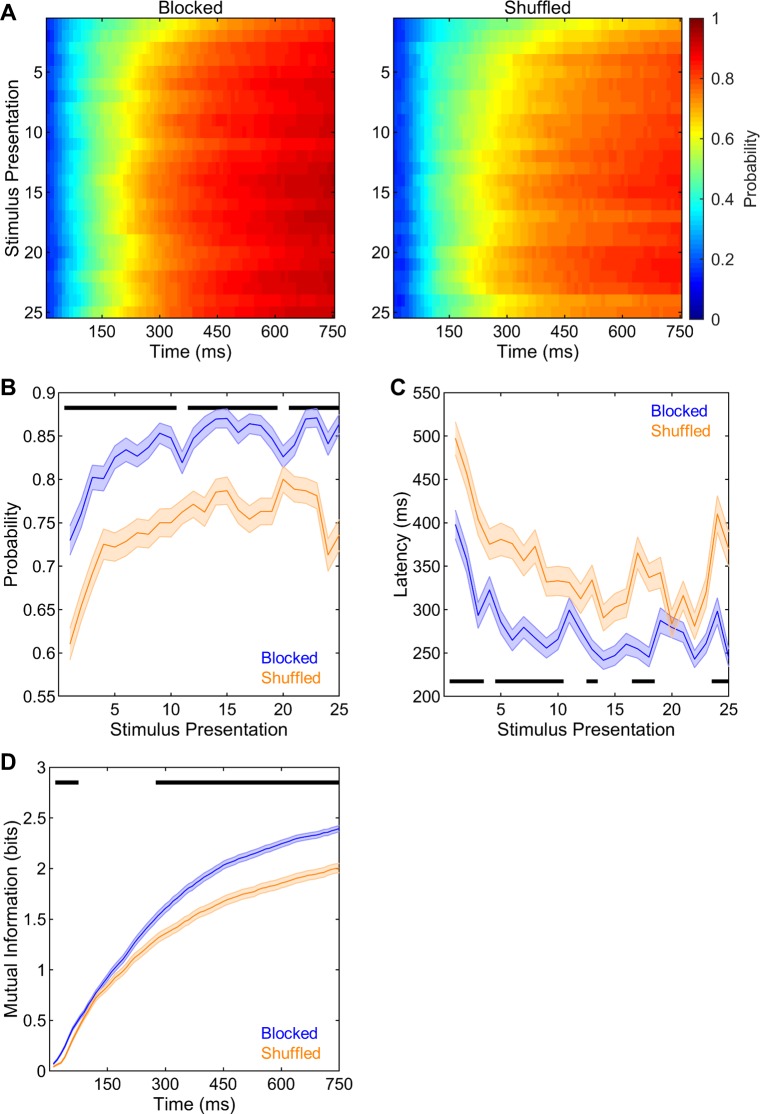
Neural decoding in blocked and shuffled sequences.(A) Neural decoding accuracies were analyzed across time points along the stimulus duration and stimulus presentations in blocked and shuffled sequences. (B) Correct neural decoding probabilities across stimulus presentations were higher in the blocked than in the shuffled sequence. (C) Correct neural decoding latencies across stimulus presentations were shorter in the blocked than in the shuffled sequence. (D) Mutual information was higher in the blocked than in the shuffled sequence between the 2nd and 7th time bins (20–70 ms) and from the 28th time bin until the end of the stimulus period (280–750 ms). Shadings indicate SEMs. Horizontal black bars denote significant differences.